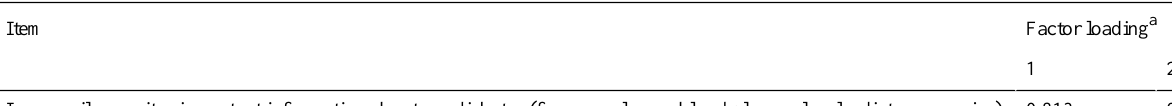
Table 2. DSMT-Q factors and item loadings on the Structure matrix.